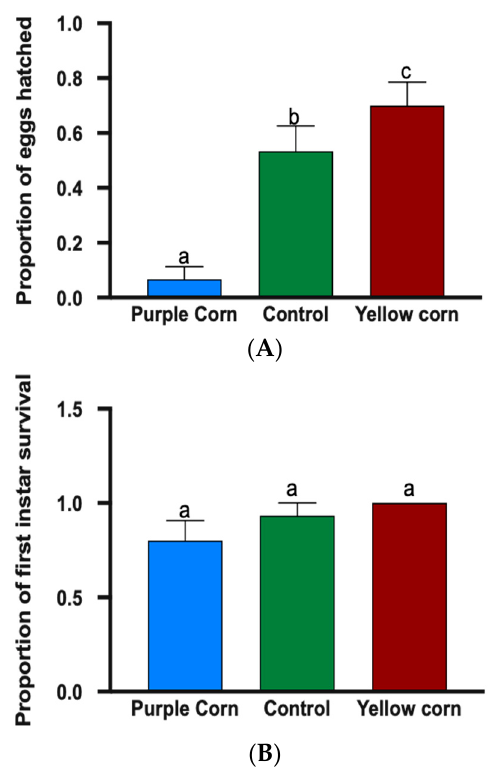
Figure 3. Proportion of eggs hatched ( A ) and mean first instar survival ( B ) among different treatments. Means followed by different letters are significantly different (Kruskal – Wallis tests, Means followed by di ff erent letters are significantly di ff erent (Kruskal–Wallis tests, Dunn’s multiple Dunn’s multiple comparison test, p < 0.05). comparison test, p <